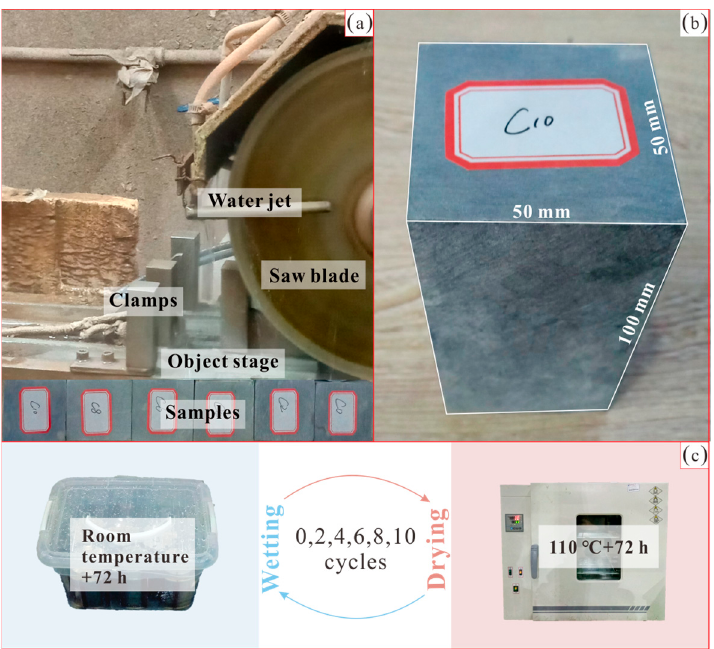
Figure 4. Sample preparation by cutting ( a ), sample size ( b ) and cyclic wetting and drying test ( c ).